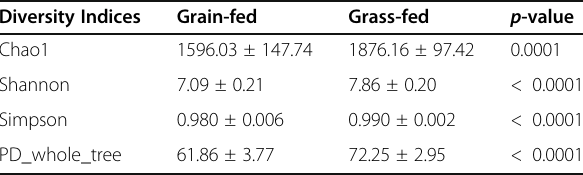
communities Diversity Indices